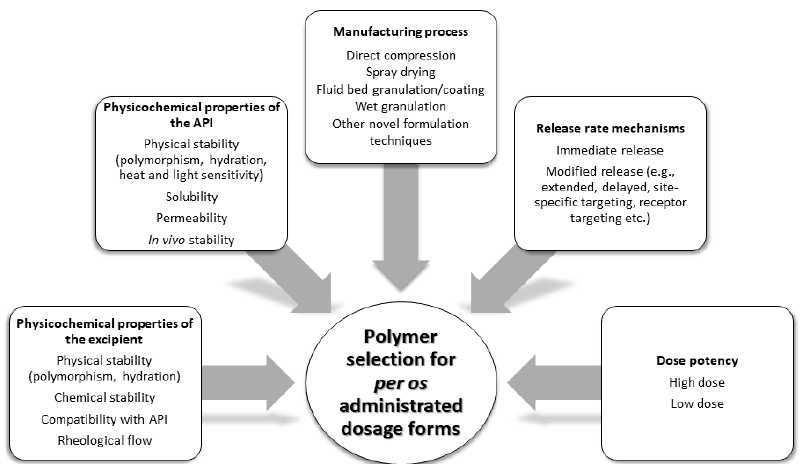
Figure 6. Parameters that are essential on selecting polymers for per o s administrative dosage